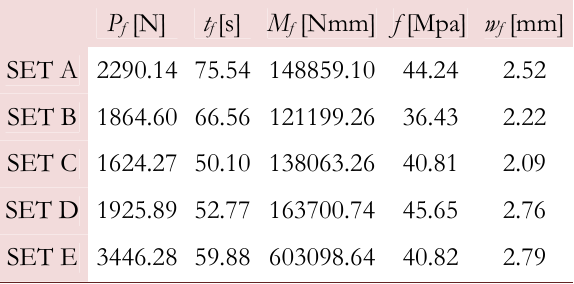
Table 3: Mean values at failure for each